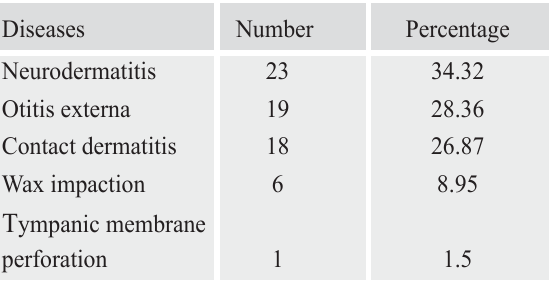
Table III: Types of diseases of external ear of the cases